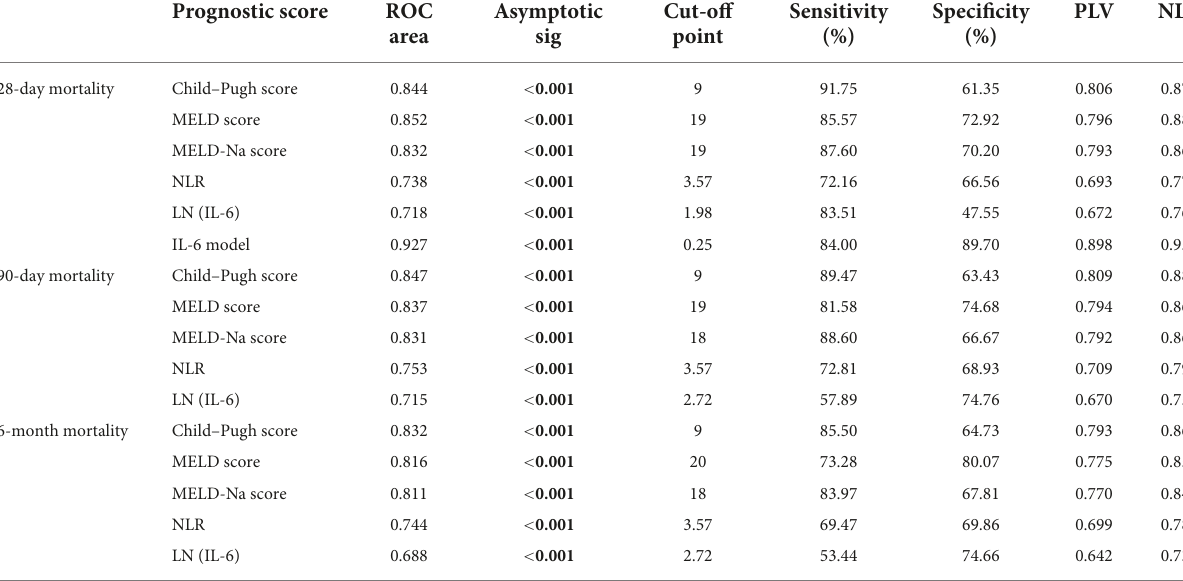
TABLE 4 The efficacy of the various systems for prediction 28-day, 3-month, and 6-month mortality. Prognostic